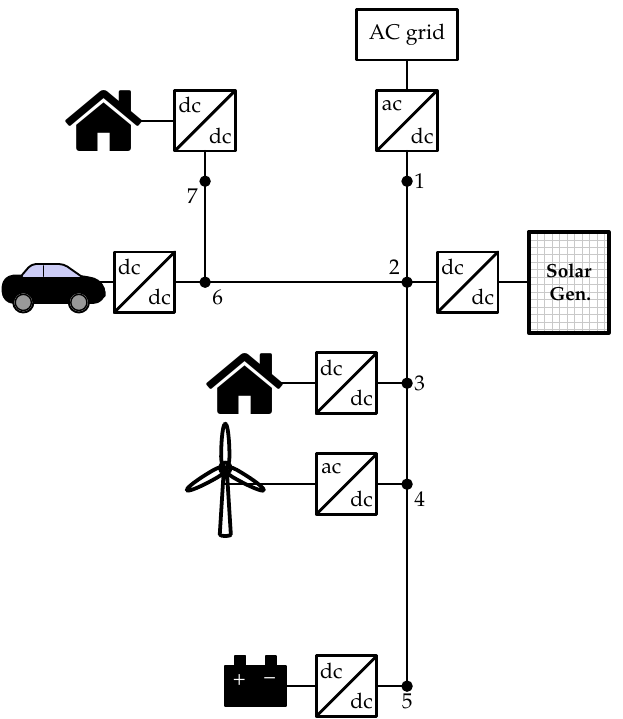
Figure 1. Example of a seven-bus DC Microgrid that allows the incorporation of distributed genera- tion based on renewable sources, energy storage elements and